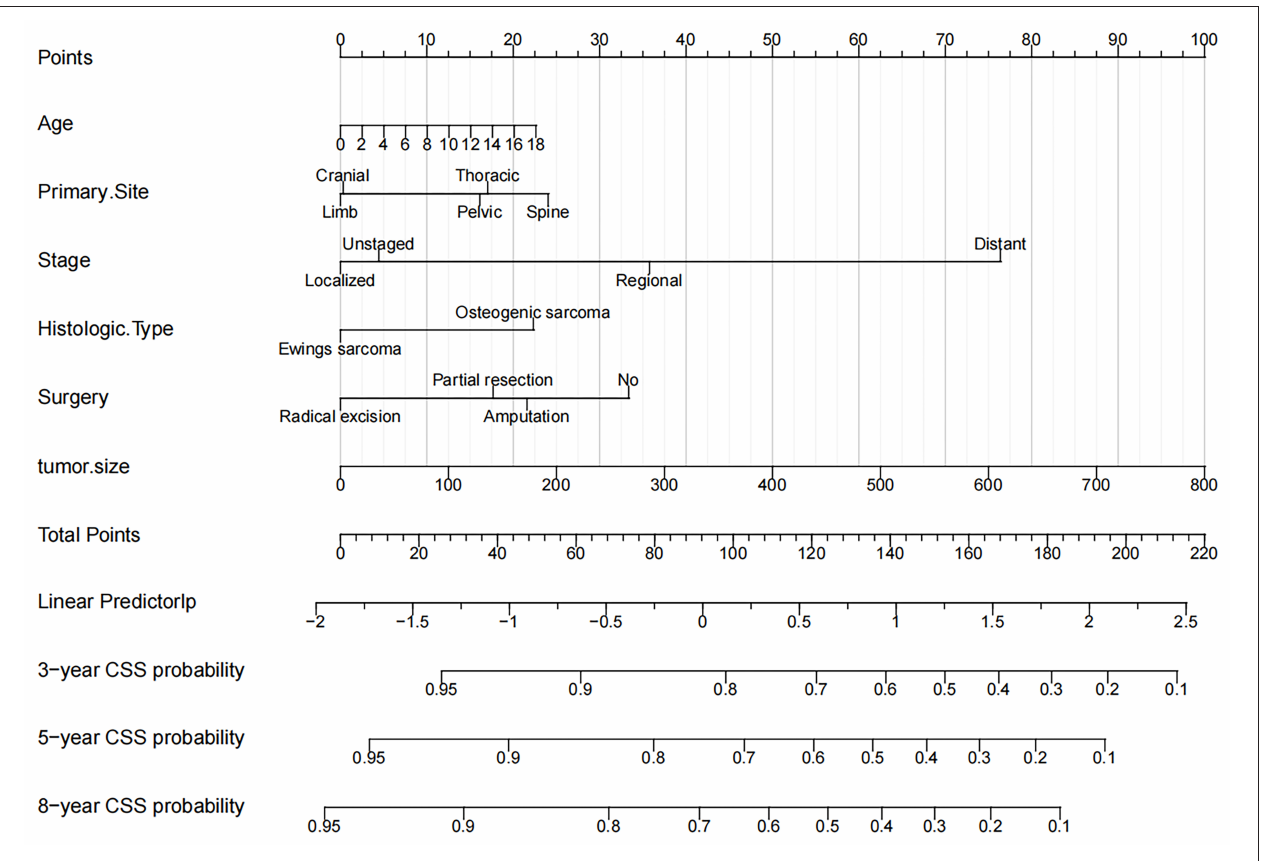
FIGURE 2 | Nomogram for 3-, 5-, and 8-year CSS of children with OSC and